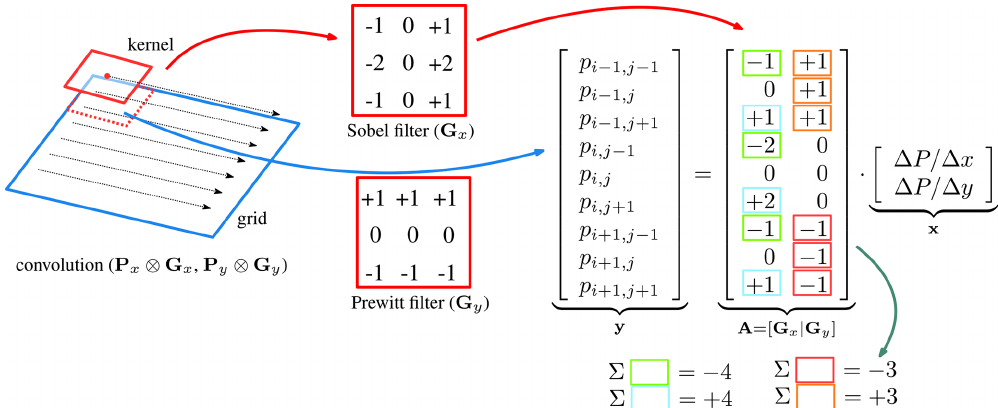
Figure C1. Schematic of a computation of a convolution, in this case the first derivative in the vertical and horizontal